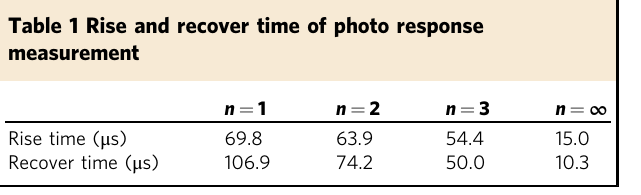
0.0 Fig. 4 Thickness-dependent photo response. a Photo response and b recovery of normalized current in 2D perovskite with n = 1, 2, and 3 and 3D perovskite